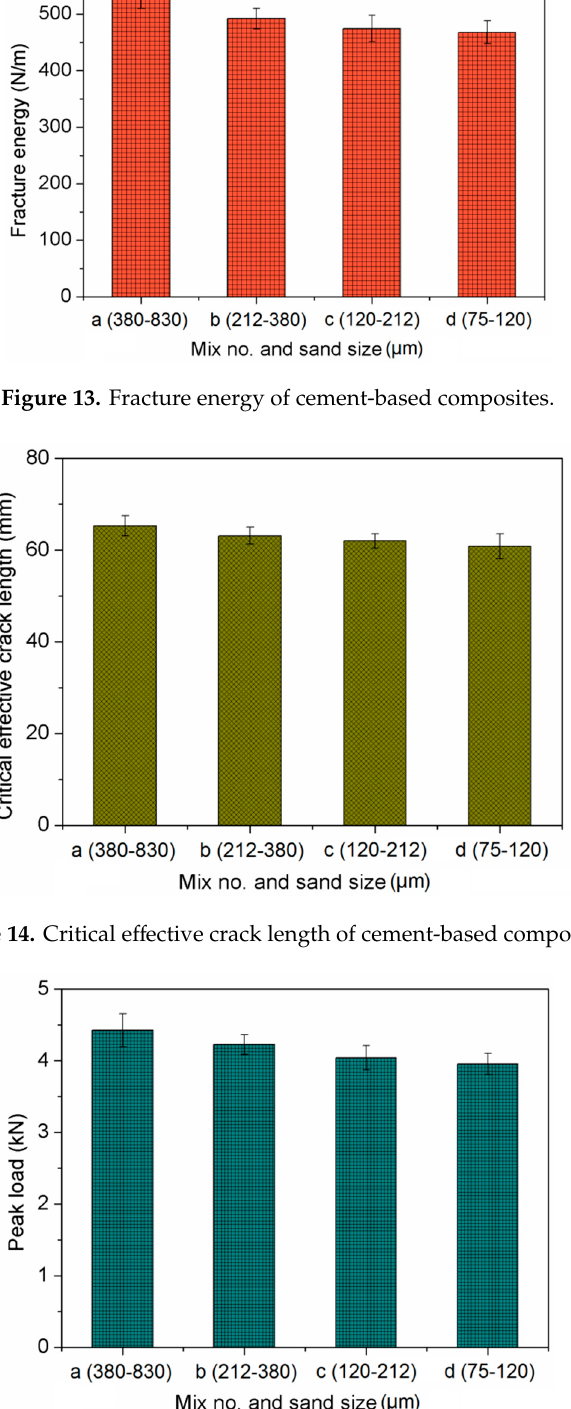
Figure 15. Peak load of specimen of cement-based composites.